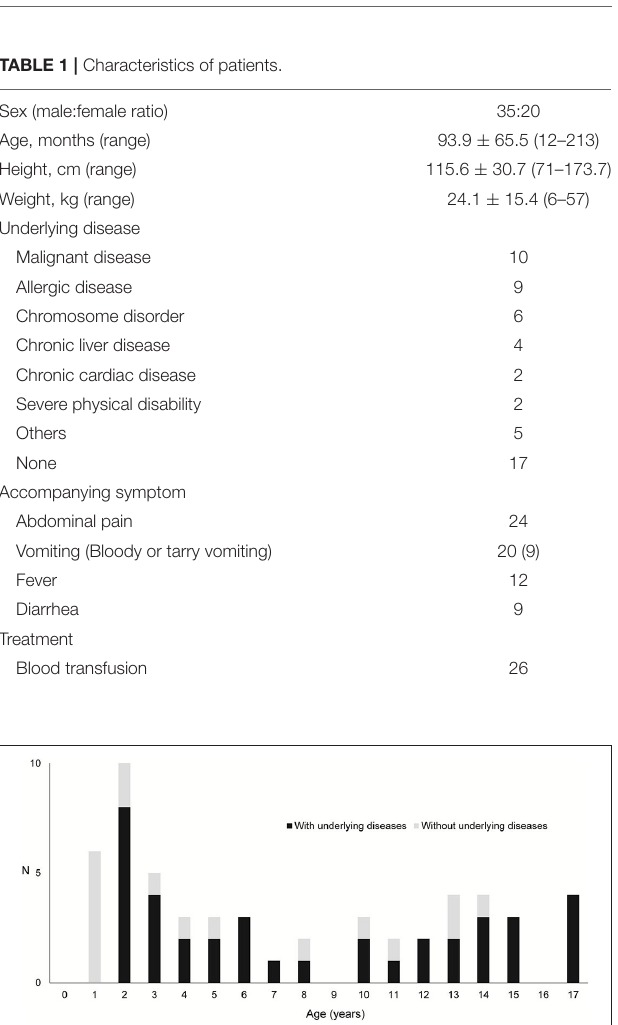
FIGURE 1 | Age distribution and presence of underlying